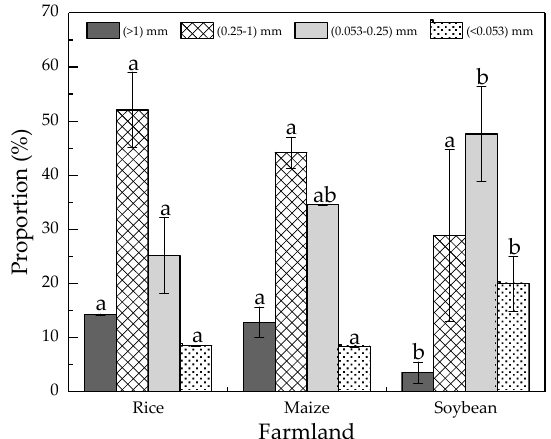
Figure 1. Variation in soil aggregate fractions of farmland. Note: the letters a, b indicate the significant difference in the amount of the same grain-size soil aggregate under different land uses.